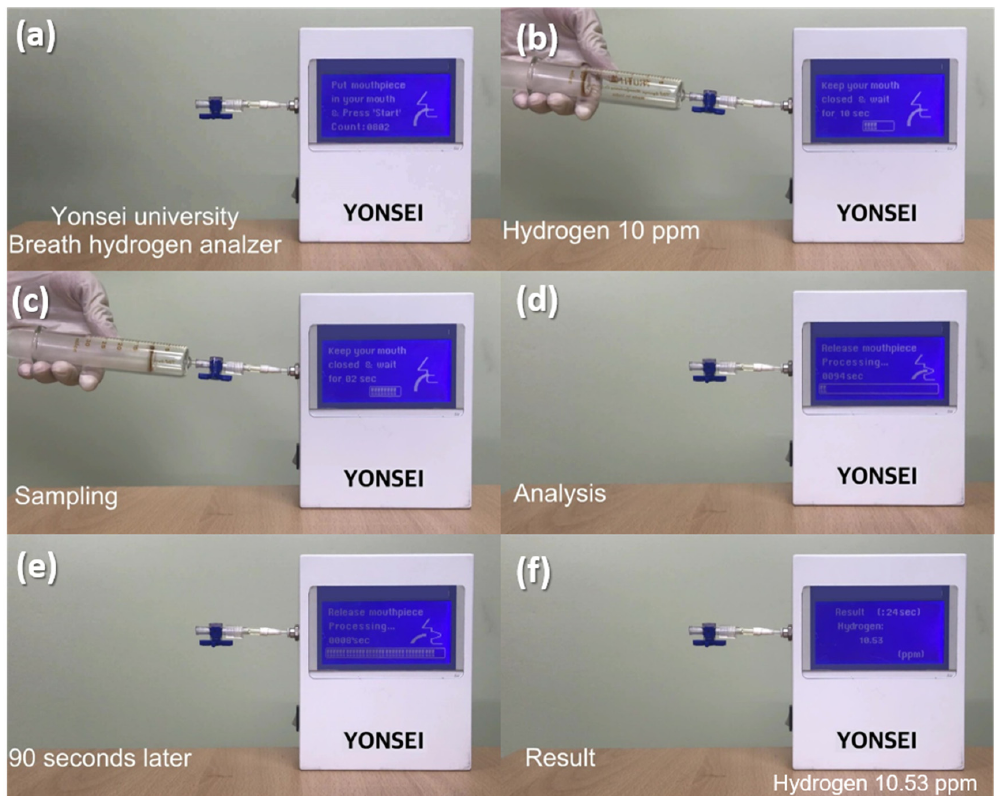
Figure 7. Real-time hydrogen gas sensing test via the manufactured hydrogen gas analyzer, consisting of Pd-coated SnO 2 NR sensor and mini-GC, using 10 ppm of standard hydrogen gas. ( a ) Put mouthpiece in you mouth and Press the start button, ( b ) Injection of a standard test gas of 10 ppm hydrogen, ( c ) Gas sampling for 20 s, ( d ) Starting gas analysis, ( e ) After 90 s of gas analysis, and ( f ) Display of the gas analysis result.